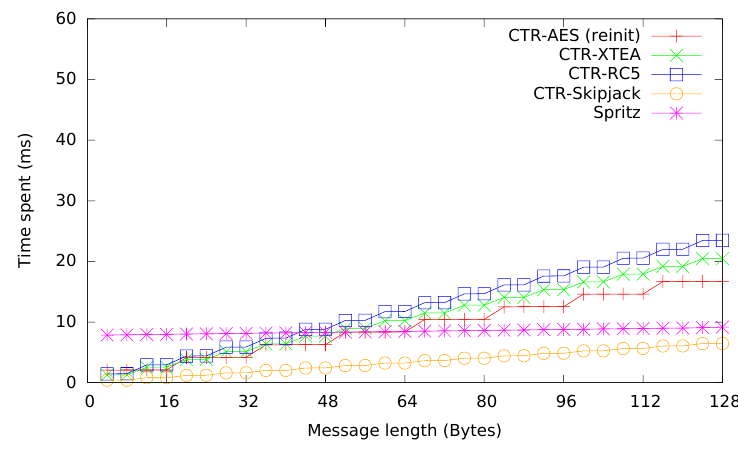
Figure 6. Ciphers in counter (CTR) mode.